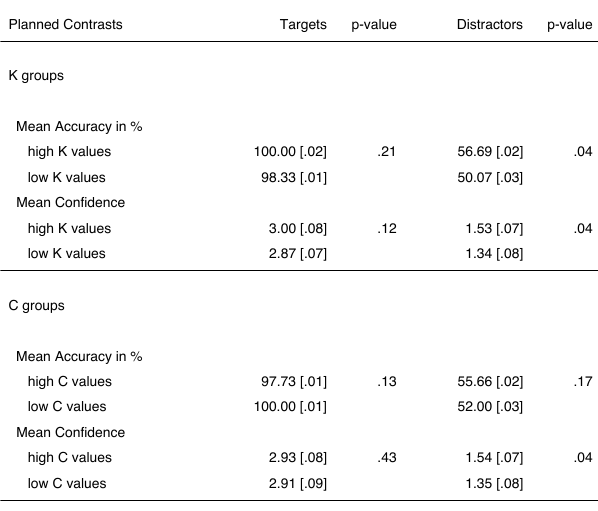
Table 1: Summary of mean values Accuracy and Confidence as a function of participant groups ("low-K-value group" vs. high- K-value group", "low-C-value group" vs. "high-C-value group") split for targets and